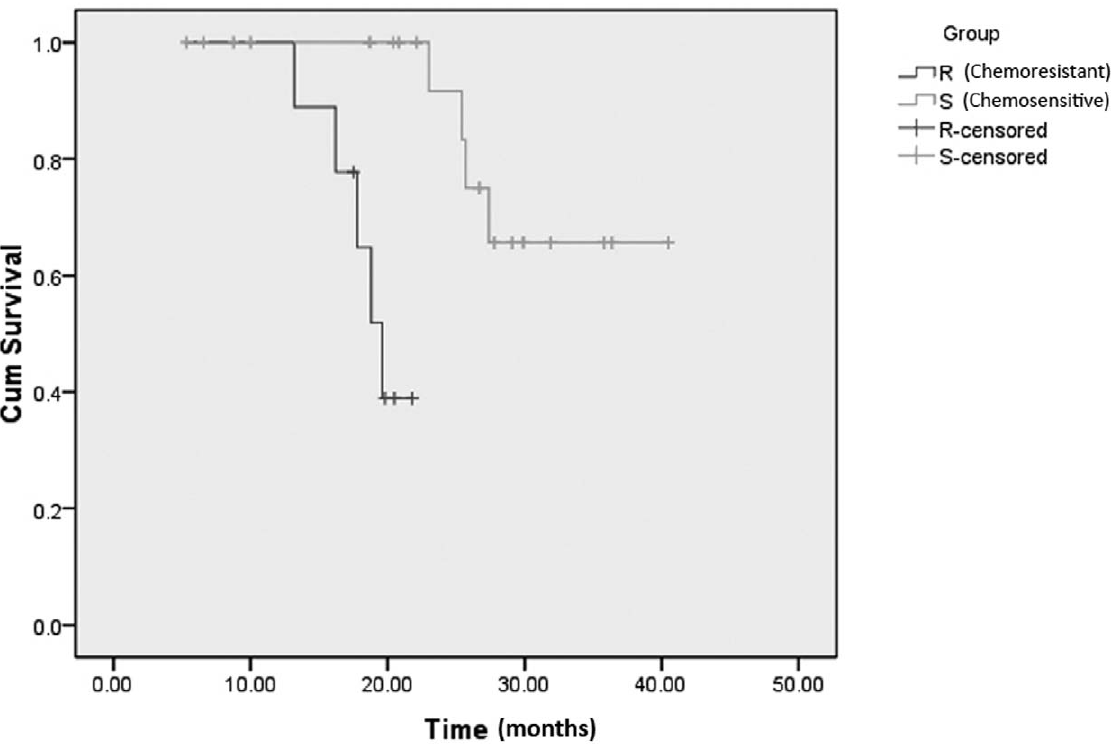
Figure 1. Comparison of survival between chemosensitive and intrinsic chemoresistant serous EOC patients. A significant difference ( P = 0.007) was observed in survival, which favored patients with chemosensitive tumors.